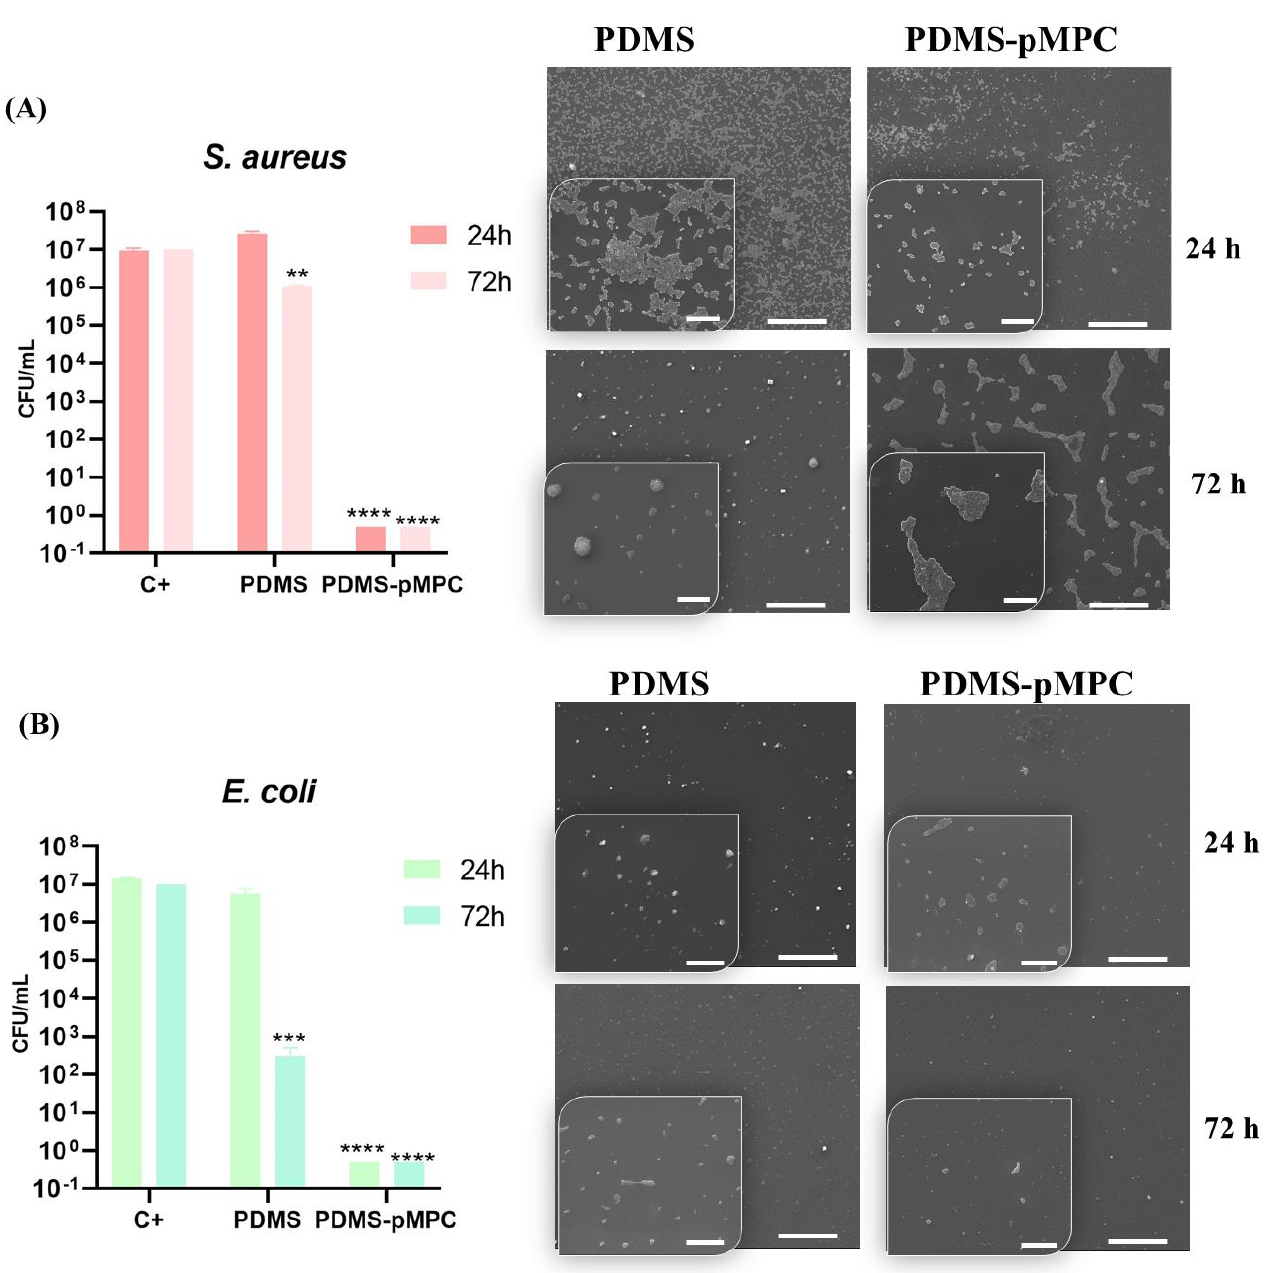
Figure 9. Colony forming unit (CFU) analysis of ( A ) S. aureus and ( B ) E. coli after 24 and 72 h treatment with PDMS loaded with MPC and soft PDMS. The positive control is represented by pure bacterial culture in the absence of substrates. SEM images are after 24 and 72 h of incubation with S. aureus and E. coli . Scale bar: 50 µ m (insert: 10 µ m). Data expressed as mean ± SD, n = 3, (** p < 0.01, *** p < 0.001, and **** p < 0.0001 vs. C+).